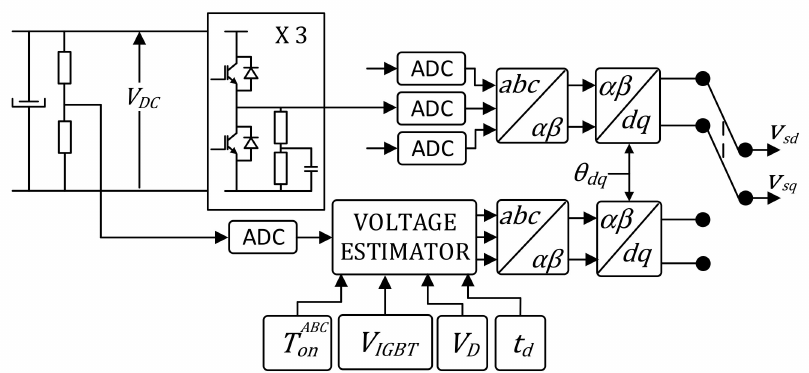
Figure 6. Principle for the measurement and estimation of voltage in the used low voltage IM drive. Voltage estimator determinates IM phase voltages based on the measured DC bus